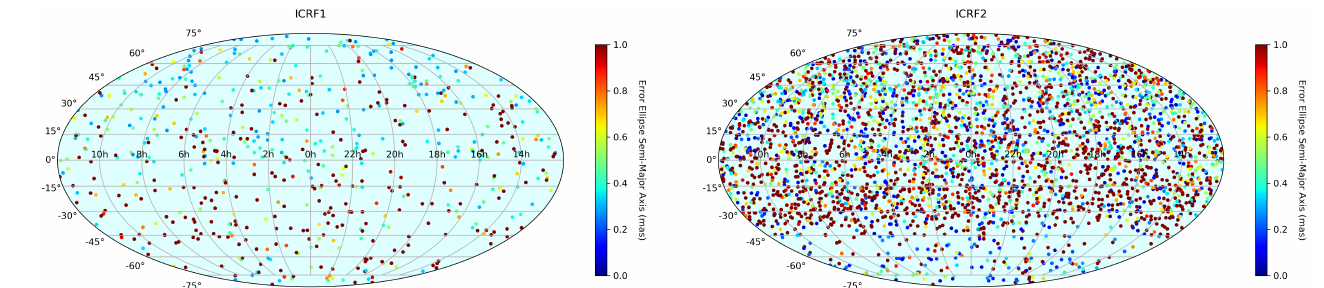
Figure 1. Sky distribution of the 608 sources in ICRF-1 ( left panel) and 3414 sources in ICRF-2 ( right panel). Each source is plotted as a dot color-coded according to its position uncertainty (defined as the semi-major axis of the error ellipse derived from the right ascension and declination uncertainties and correlation coefficients between the coordinates). The color scale ranges from 0 to 1 mas.